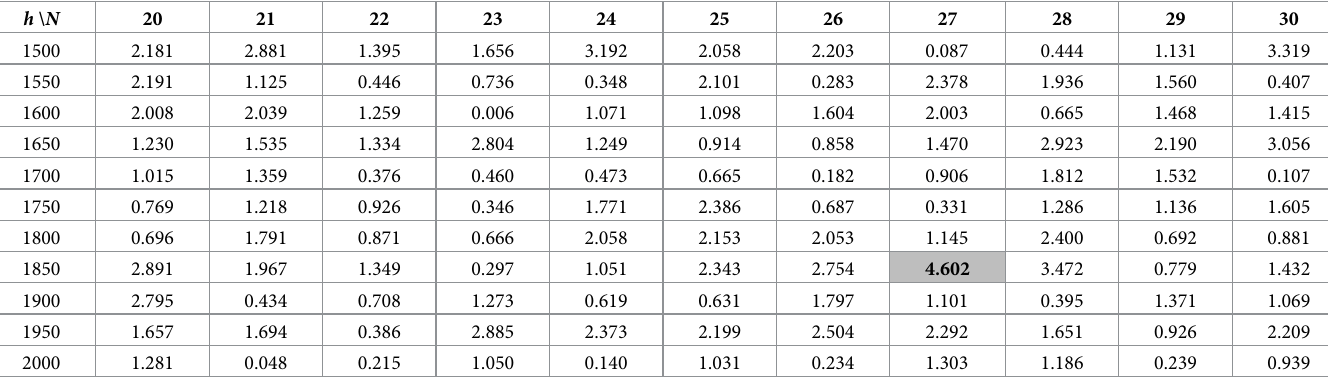
Table 6. Difference between the estimated Hurst exponent of mung beans (B) and noise signal (D) as ( − log 10 p )-values of likelihood ratio test (15).